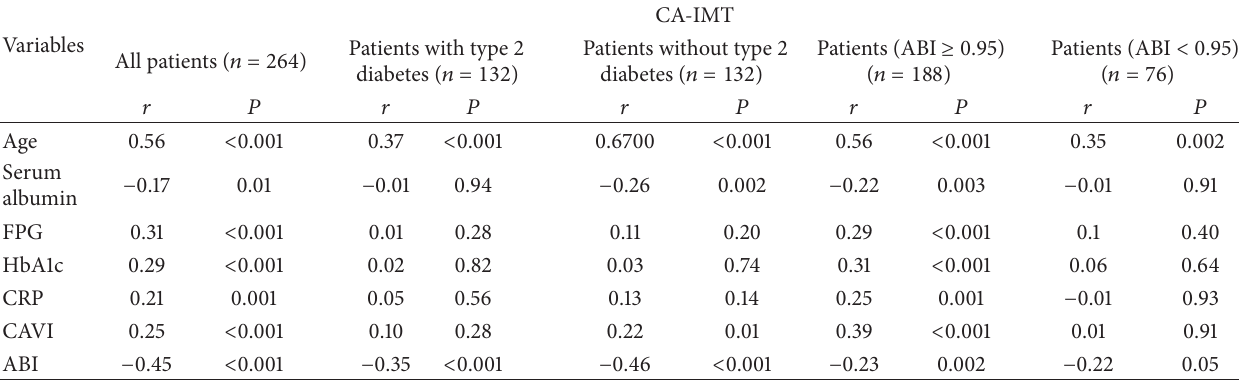
Abbreviations used in this table are the same as in Table 1. Table 5: Multivariate regression analysis of clinical variables associated with CA-IMT in all patients, patients with ABI ≥ 0.95, and patients with ABI ≥ 0.9.